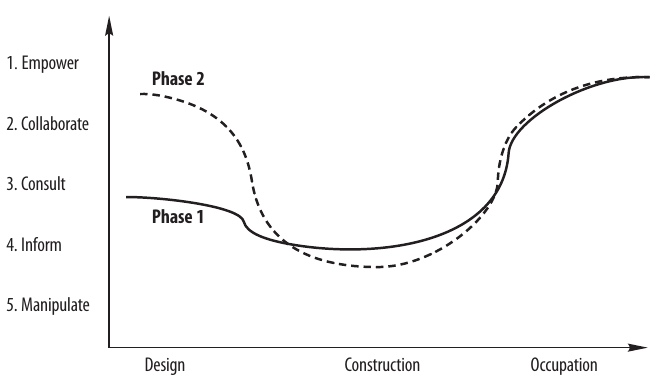
Figure 2. Mapping community involvement through project